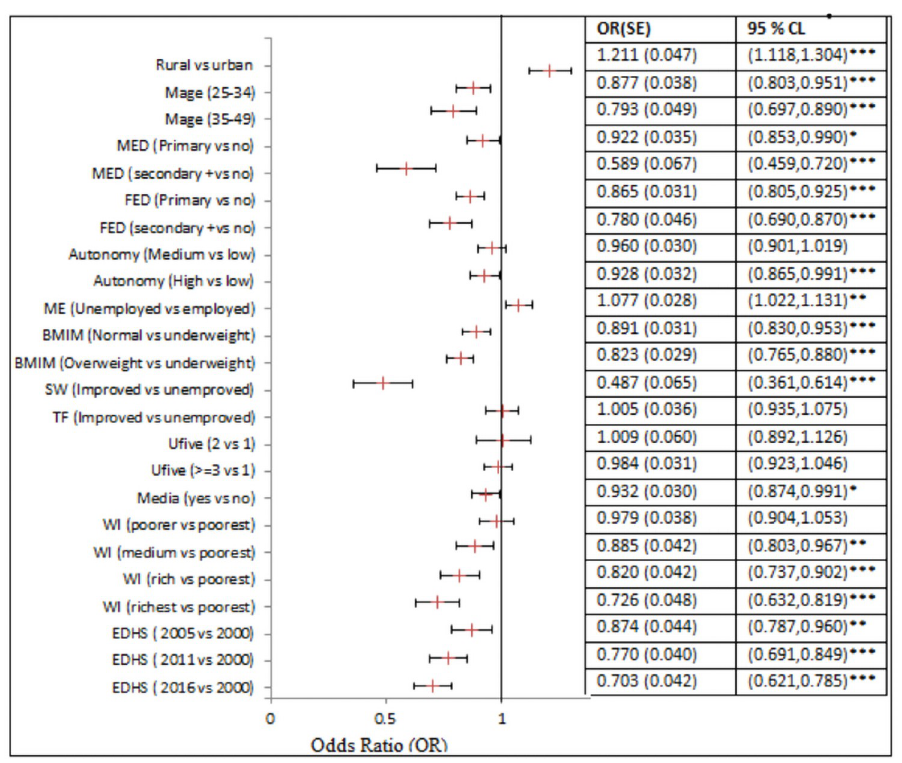
Fig 4. The fixed effects covariates related to maternal and household characteristics. https://doi.org/10.1371/journal.pone.0256726.g004 PLOS ONE | https://doi.org/10.1371/journal.pone.0256726 September 23,